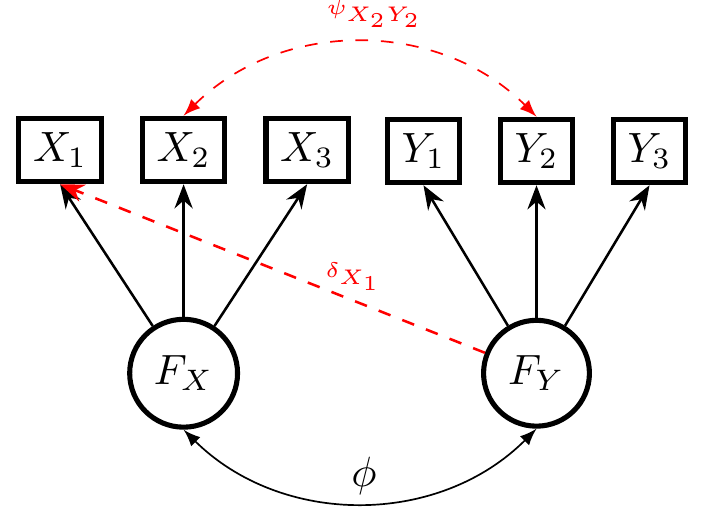
Figure 5. Simulation Study 3: Data-generating model. Residual correlations are displayed with curved dashed red double arrows. Cross loadings are displayed with dashed red